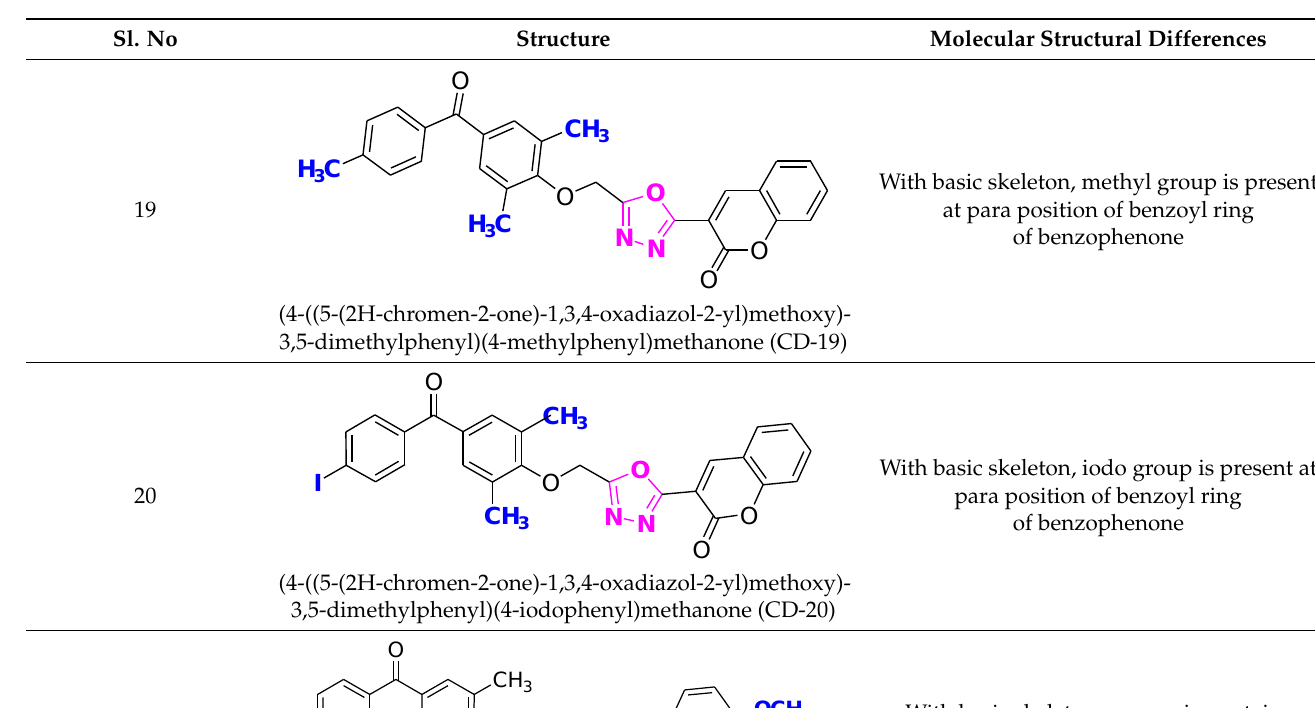
With basic skeleton, coumarin contains methoxy group at 7th position, methyl group is present at ortho position of